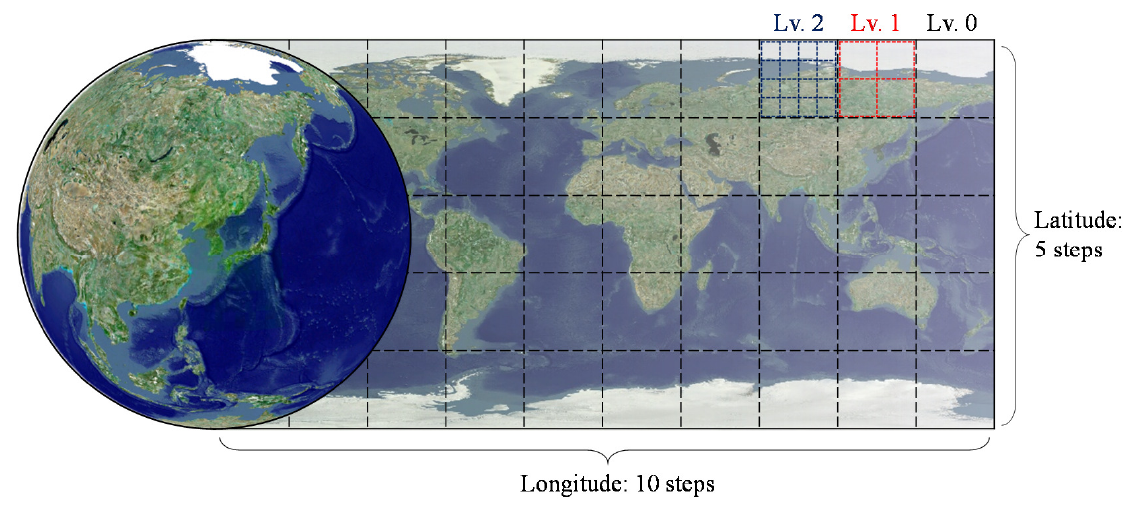
Figure 3. Tile system: level 0 tiles divide the surface of Earth into 5 latitude steps and 10 longitude steps. When a level 0 tile is divided into four or sixteen smaller tiles, the smaller tiles become, respectively, level 1 or level 2 tiles.